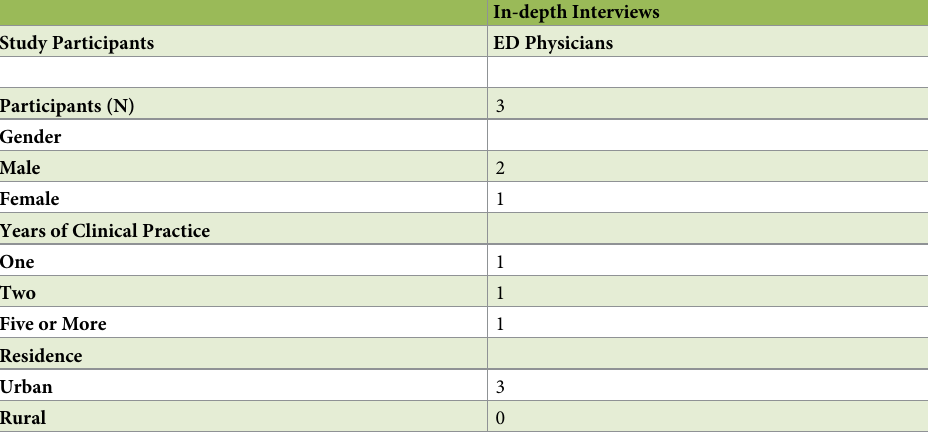
Table 2. Characteristics of the in-depth interview participants.